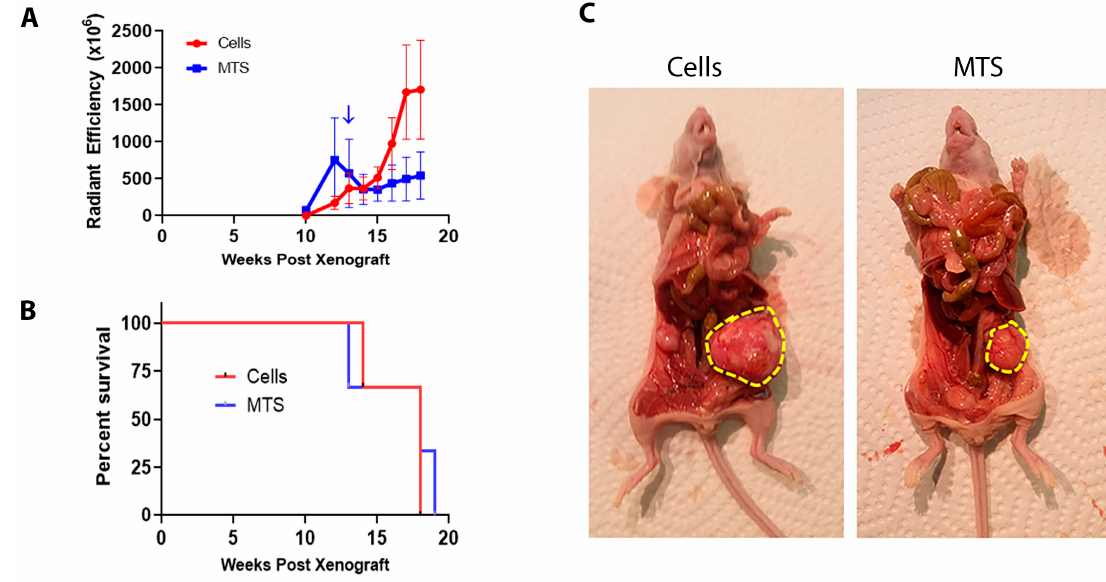
Figure 7. OVCAR8 RFP cells grown on traditional cell culture plastic (cells) or as MTS prior to being xenografted into the ovarian bursa are equally aggressive. ( A ) Average radiant efficiency ([p/s/cm 2 ]/[ μ W/cm 2 ]) ± SEM in mice with OVCAR8 cells tagged with RFP and xenografted as loose cells or MTS into the left ovarian bursa. ↓ represents when the mouse was sacrificed at a humane endpoint. Analyzed by two-way ANOVA. No significant differences were detected. n = 3. ( B ) Kaplan-Meier survival curves for mice in both treatment groups. Analyzed by log-rank (Mantel-Cox) test. No significant differences were detected. n = 3. ( C ) Representative images showing large ovarian tumors (circled in yellow) found in both treatment groups.